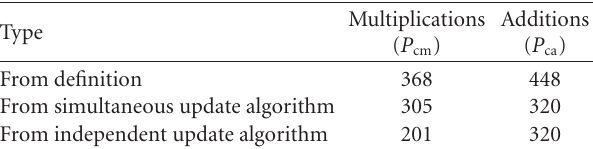
Table 1: Comparison of power consumption.